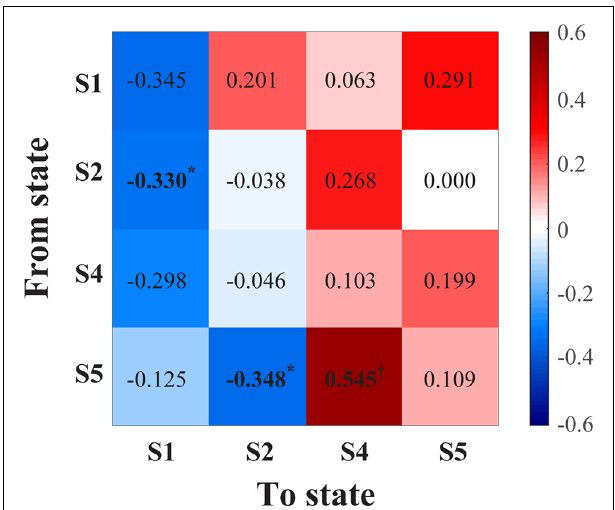
FIGURE 2 | Correlation matrix (Spearman’s rho) between age and transition probability from a given connectivity state (y-axis) to another state (x-axis). ∗ Indicates P < 0.05, but the values did not meet the critical threshold for significance via Benjamini–Hochberg criteria; † indicates statistical significance ( P = 0.001) meeting Benjamini–Hochberg threshold criteria. S1, prefrontal-frontal alpha-beta connectivity; S2, prefrontal-frontal alpha connectivity; S4, frontal-parietal theta connectivity; S5, frontal-parietal theta-alpha